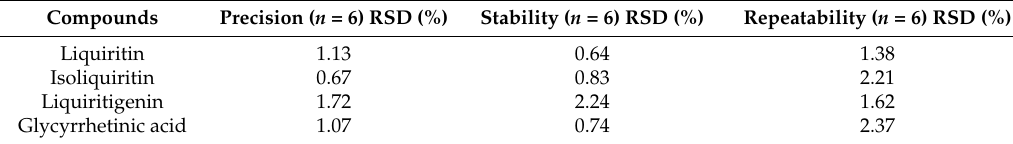
Table 5. Validation of HPLC analysis method in terms of precision, stability and